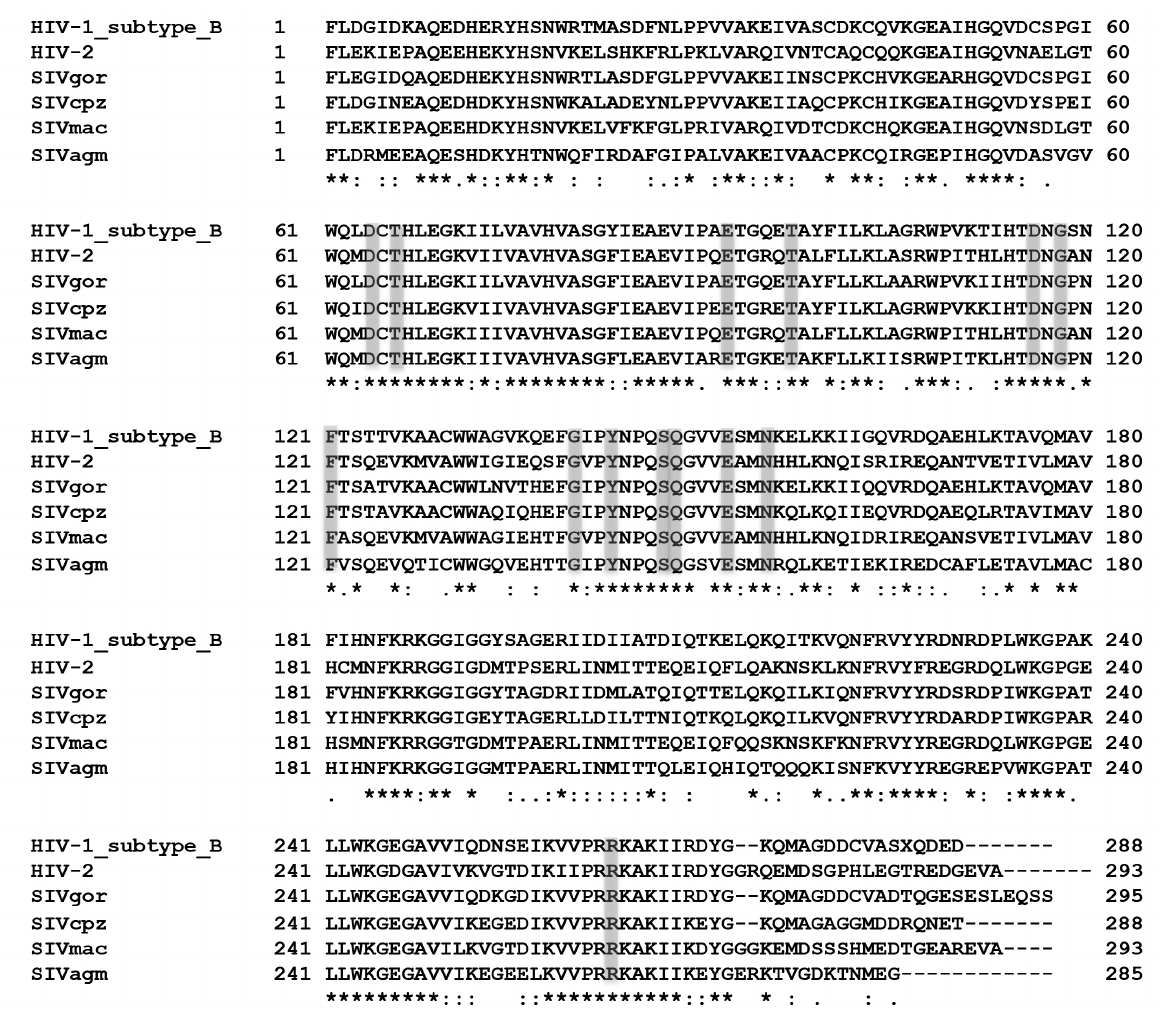
Figure 1. Multiple amino acid sequence alignment of HIV-1 subtype B and different SIV integrases. The HIV-1 subtype B integrase sequence is provided as a reference. Identical amino acid residues that are conserved across all six proteins are marked with an asterisk (*); residues similar to each other are marked with a colon (:); those that are less similar are marked with a period (.); and those that are not similar are not marked. Catalytic triad residues (D64, D116, and E152) and residues involved in main resistance pathways against integrase inhibitors (T66, E92, T97, G118, F121 G140, Y143, S147, Q148, N155, and R263) are shaded in gray. The GenBank accession numbers for the sequences used in this alignment are DQ676870 (HIV-1 subtype B), DQ307022 (HIV-2) FJ424864 (SIV CP2139.1con), EF394356.1 gor (SIV Tan1.910), M33262 (SIVmac239), and U58991 (SIV Tan-1). The multiple sequence alignment was cpz agm performed using Clustal Omega software [ 27-29